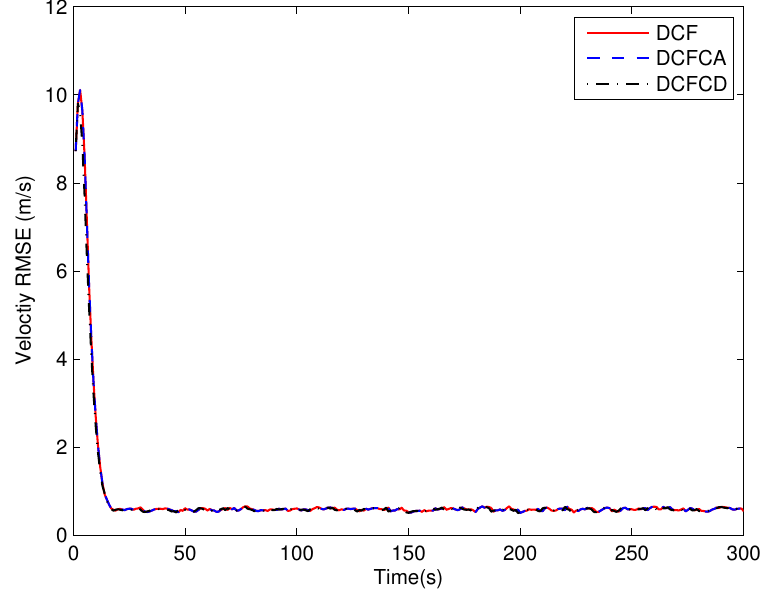
Figure 12. The velocity RMSE for different methods over time under white Gaussian